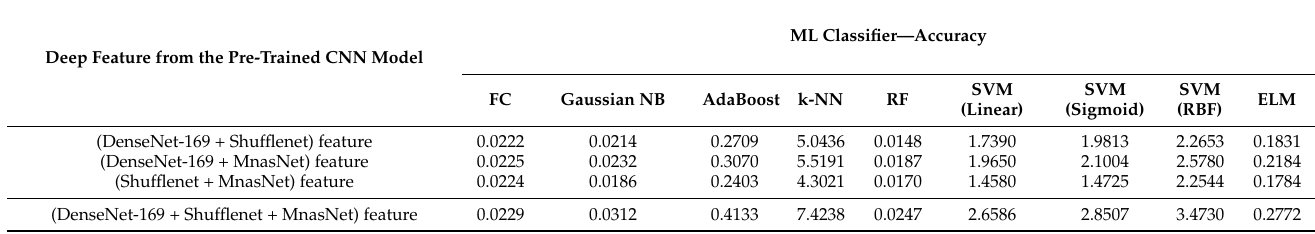
Table 10. Computational complexity of ensemble of pre-trained CNN models with ML classifiers on BT-large-4c dataset. Deep Feature from the Pre-Trained CNN Model